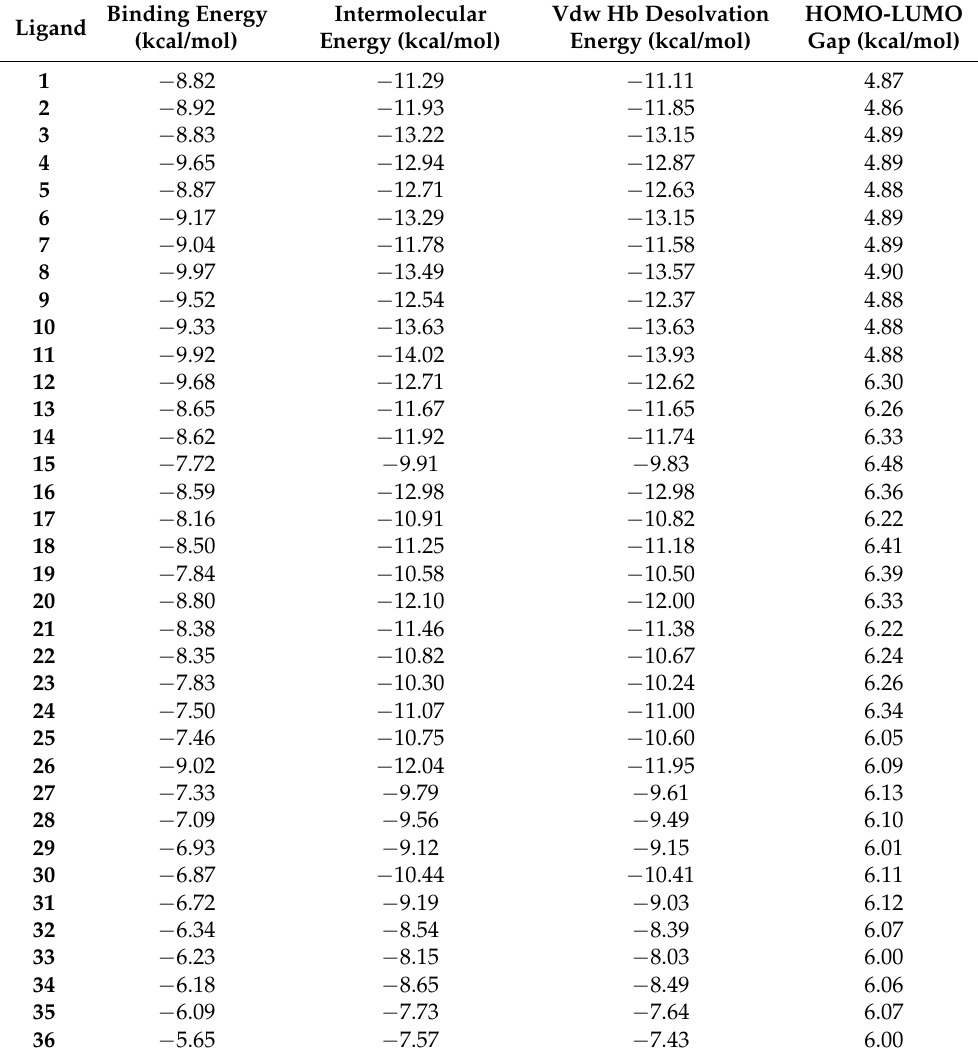
Table 1. Molecular docking and DFT-B3LYP calculated parameters for protein 11 β -HSD1-ligands 1 – 36 complexes and single